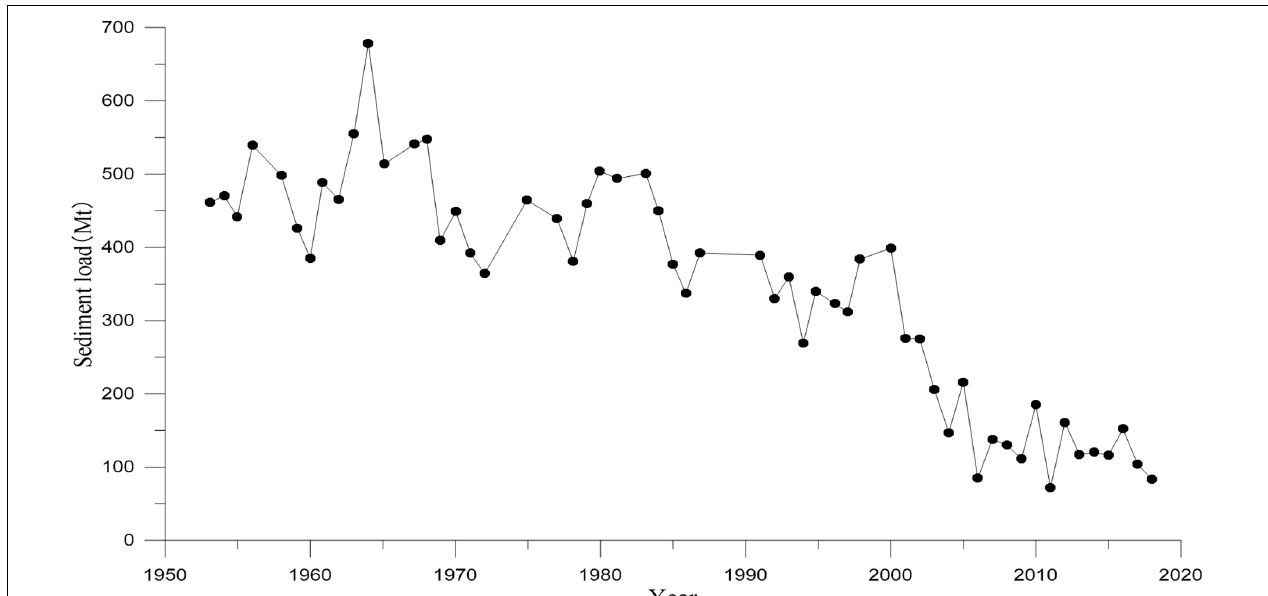
FIGURE 11 | Suspended sediment load changes over a 66-year period (1953–2018) at Datong Station.